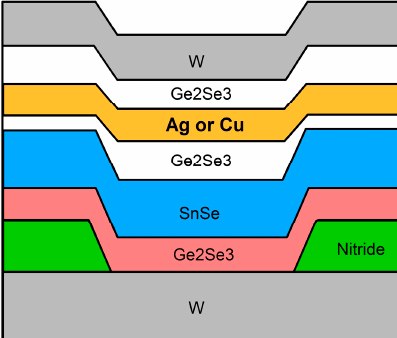
Figure 1. Self-directed channel (SDC) device structure described in [6]. The target layer thicknesses were (from bottom to top): Ge 2 Se 3 (300 Å) / SnSe (800 Å) / Ge 2 Se 3 (150 Å) / Ag (500 Å) / Ge 2 Se 3 (100 Å) / W (400 Å). The top three layers below the W top electrode, corresponding to Ge 2 Se 3 / Ag / Ge 2 Se 3 , mix during fabrication, becoming one conductive layer.